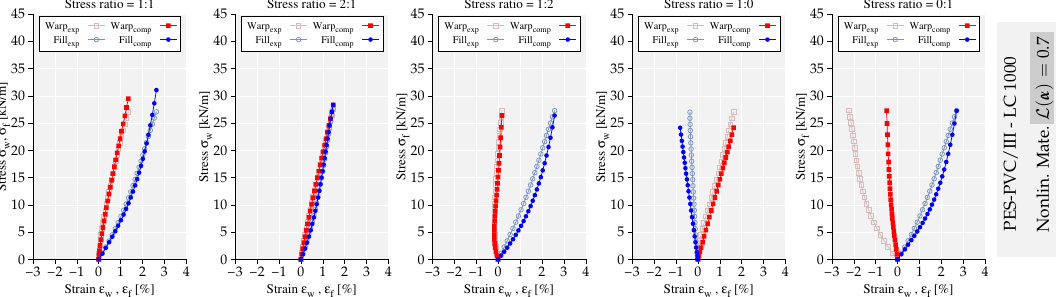
Figure 5. Mechanical response of the nonlinear material model fitting the stress–strain paths of PES-PVC/III, LC 1000. The obtained error value